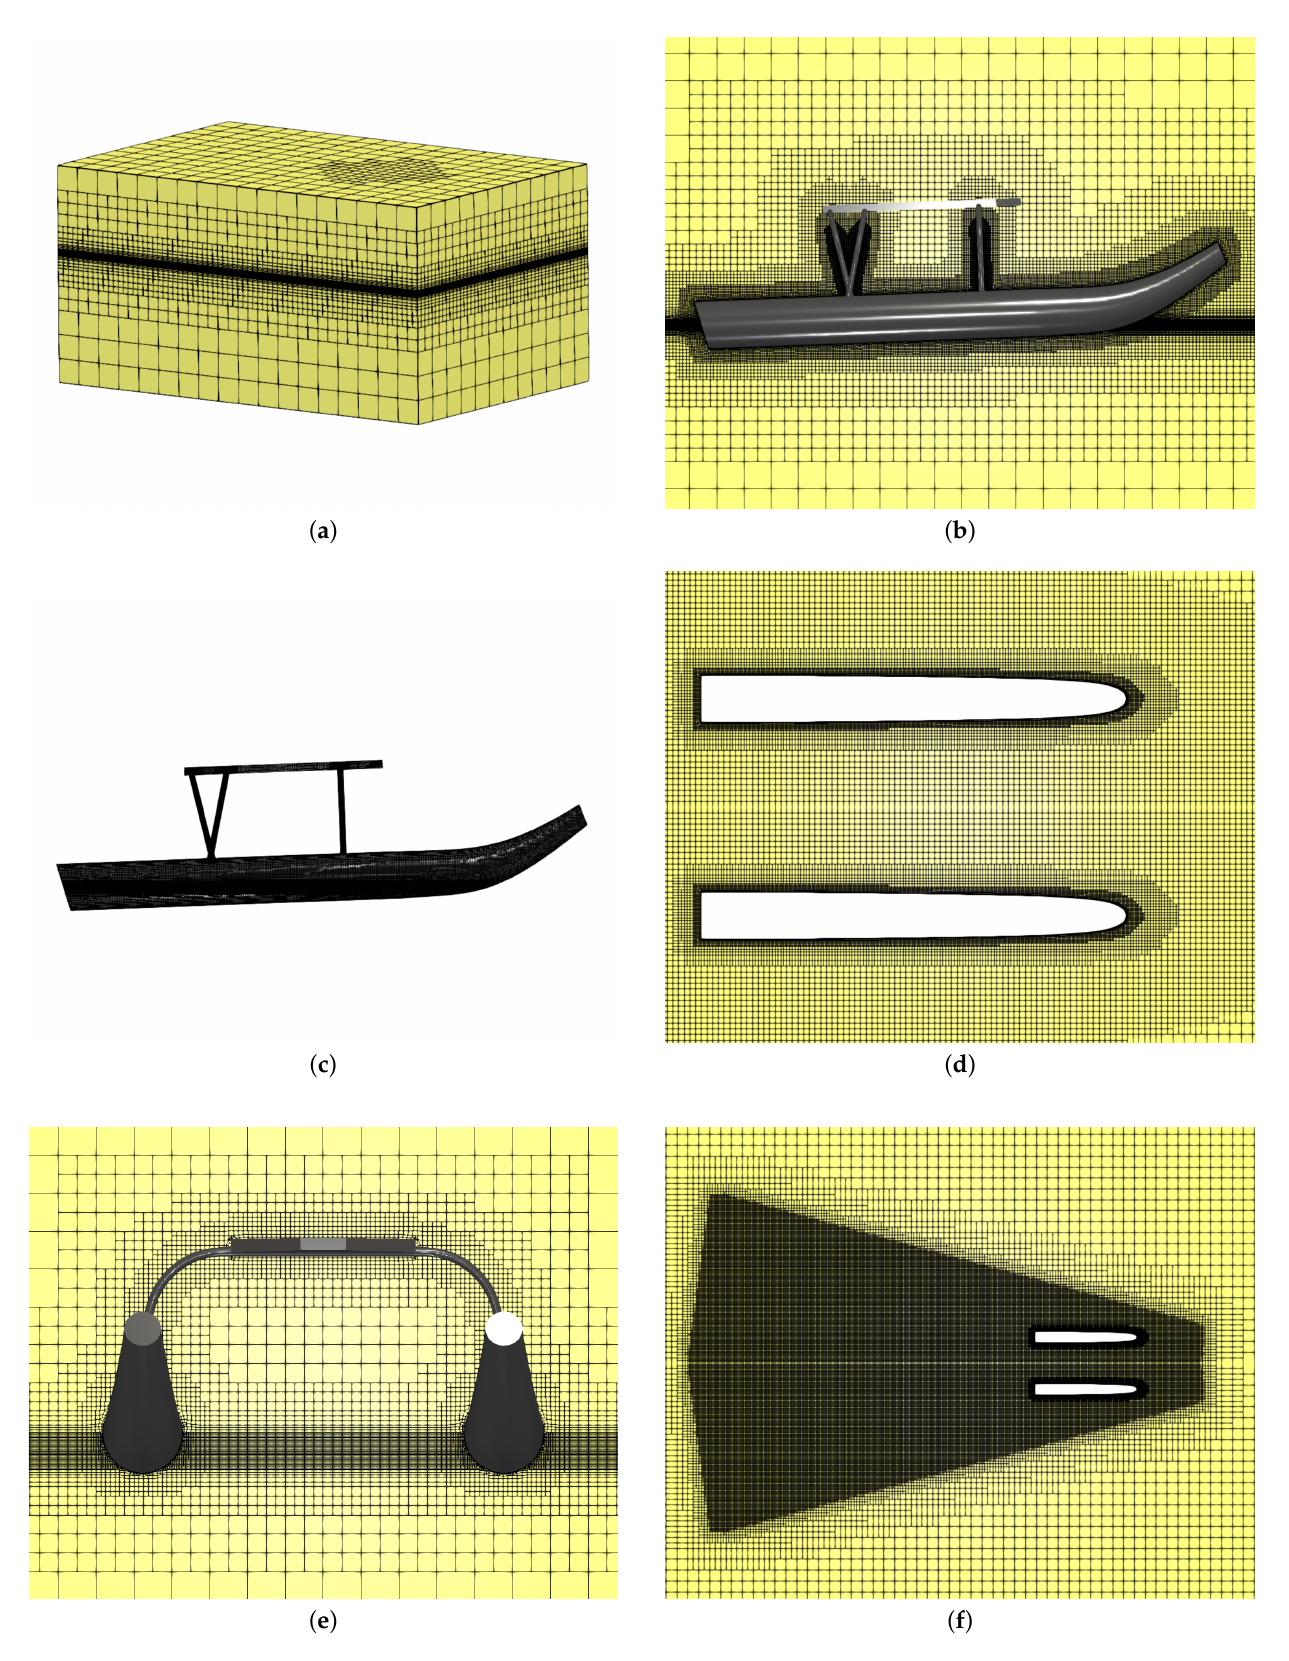
Figure 4. Mesh generation around the catamaran; ( a ) computational mesh, ( b ) mesh view on XZ plane, ( c ) mesh on the catamaran surface, ( d ) mesh refinement around the hull on XZ plane, ( e ) mesh refinement around the hull on YZ plane, ( f ) Kelvin wave refinement region around the catamaran and free